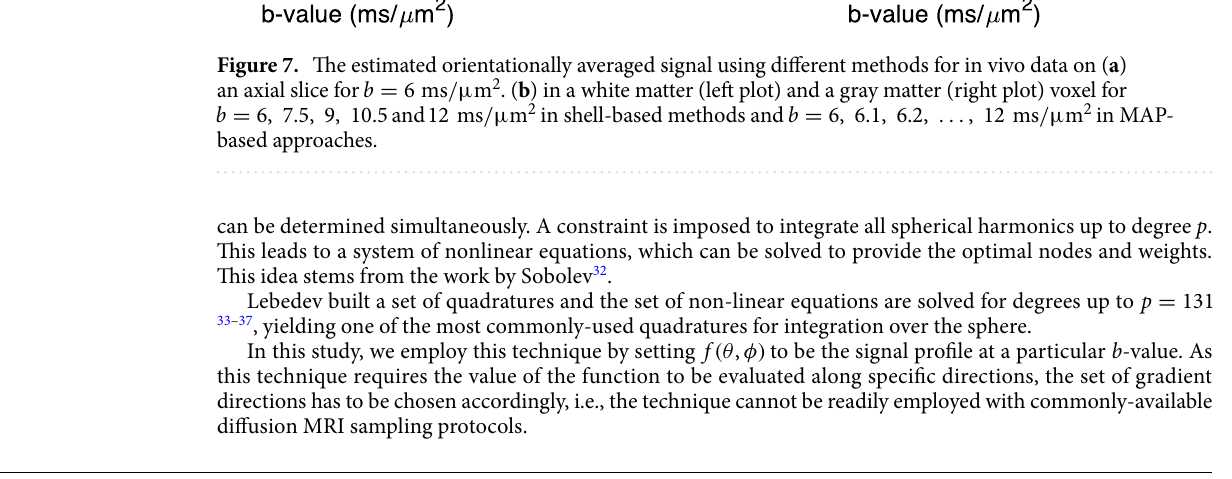
6, 6.1, 6.2, . . . , 12 ms / µ m 2 in MAP- =